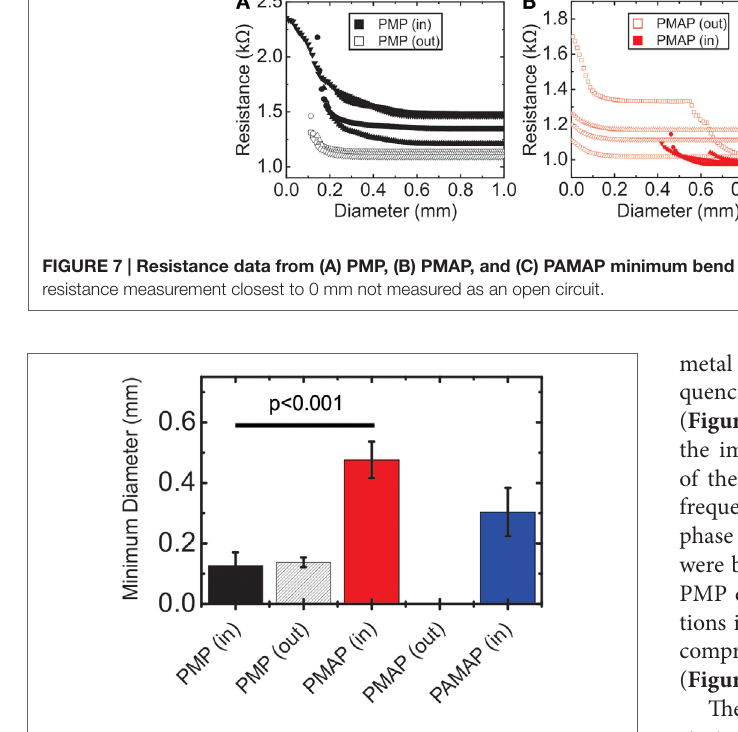
FigUre 8 | summary of minimum bend test data . PMAP (in) had a significantly larger minimum bending diameter than either PMP (in) or PMP (out) (mean ± SE, n = 3–4).